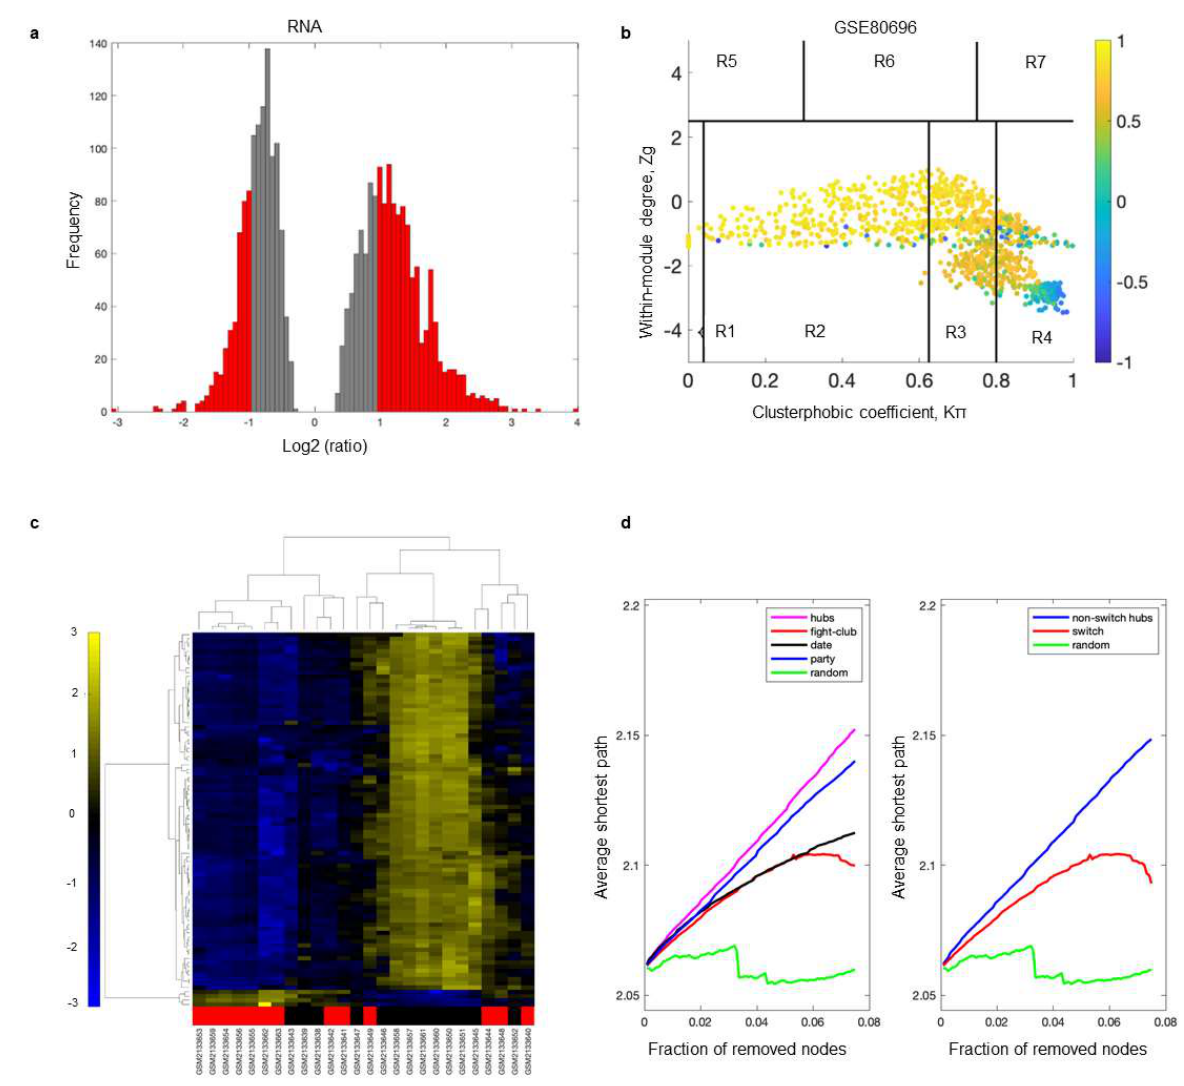
Figure 2. Identification of switch genes. SWIM analysis of postmortem nucleus accumbens of subjects with chronic loneliness compared to those with low loneliness (GSE80696). ( a ) Distribution of log2 fold change values where the red bars were selected for further analysis. ( b ) Heat cartography map with nodes colored by their average Pearson’s correlation coefficient. Blue nodes in region R4 represent switch genes. ( c ) Dendrogram and heatmap for switch genes. The red markers indicate samples from subjects with chronic loneliness. ( d ) Robustness of the correlation network.